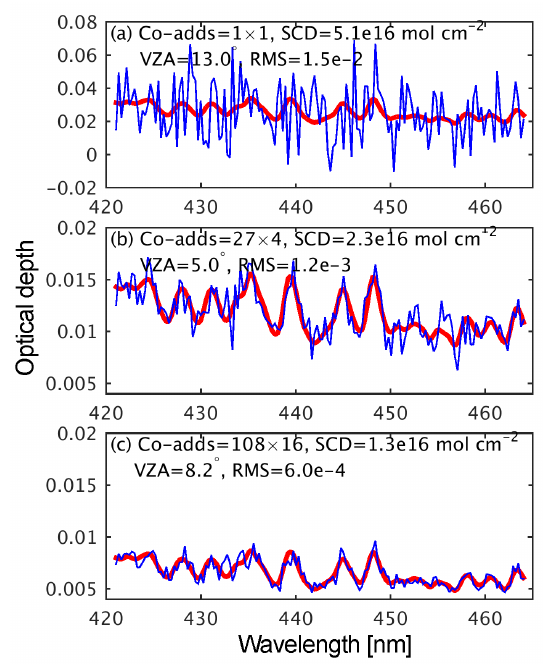
Figure 7. Sample NO 2 spectral fits showing observed (blue) and simulated (red) optical depths from spectra collected over the south of Houston (29.70 ◦ N, 95.24 ◦ W) on 13 September 2013 at 10:46LT, with a solar zenith angle (SZA) of 44.1 ◦ , for (a) native resolution (no co-adding); (b) 250m × 250m resolution (27 × 4 co- adds); and (c) 1km × 1km resolution (108 × 16